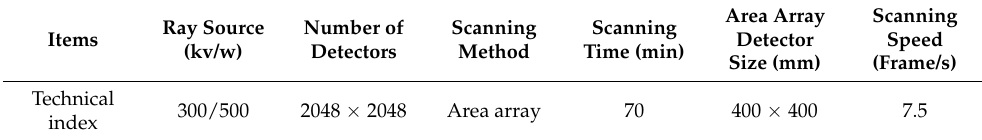
Figure 7. Schematic diagram of CT scanning. ( a ) Schematic diagram of CT scanning principle. ( b ) Schematic diagram of the CT scanning process. ( b ) Schematic diagram of the CT scanning process. Table 1. Physical parameters of soil in cyclic freeze–thaw